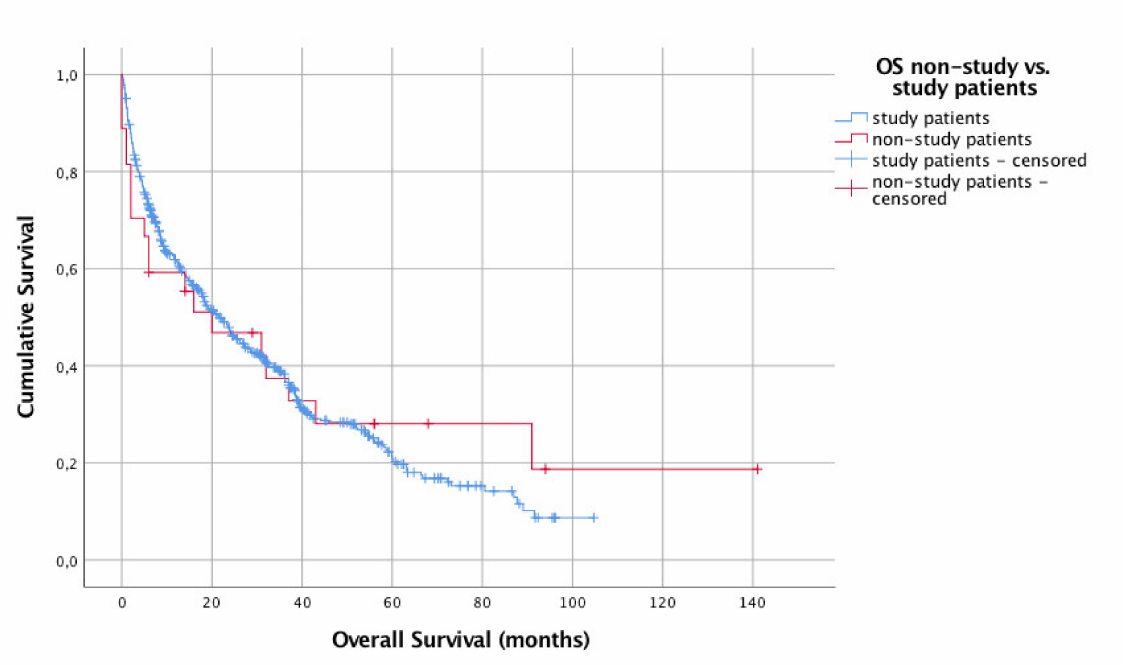
Figure 3. Overall survival of non-study ( n = 27) vs. study patients ( n =